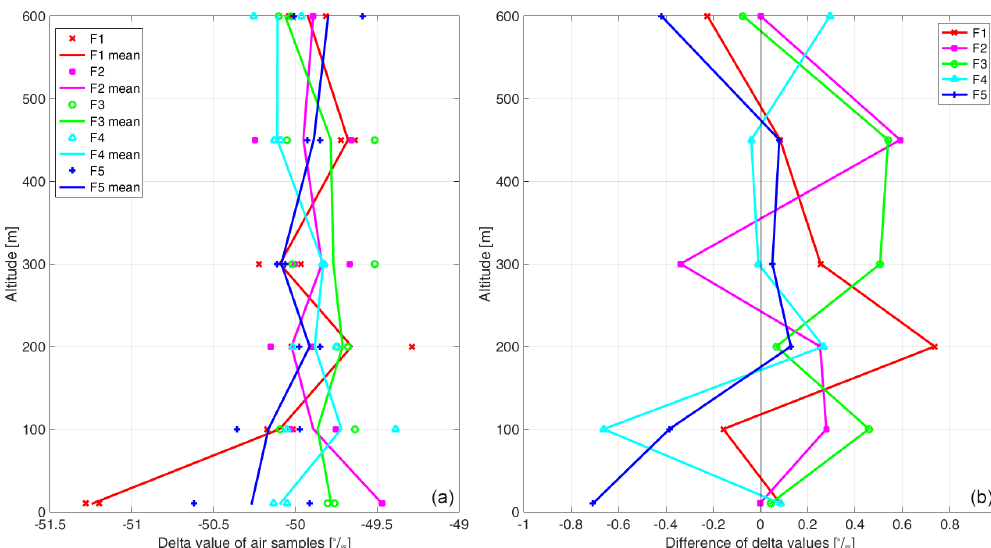
Figure 10. Profiles of (a) δ 13 C values for all air samples during the flights on 5 September 2018, and (b) difference of delta values between the double samples filled simultaneously at the same altitude.